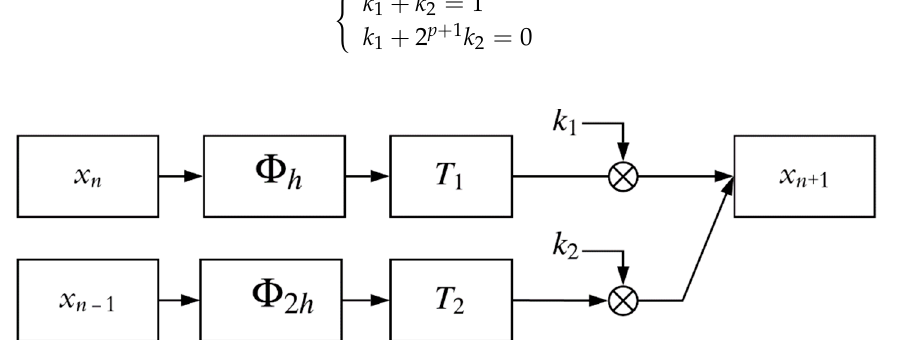
Figure 1. Graphical interpretation of the proposed multistep algorithm: solution T 1 obtained with stepsize h from the point x n and solution T 2 obtained with stepsize 2h from the point x n − 1 are combined to obtain a higher-order solution. Basic integration methods are denoted as Φ h and Φ 2 h with respect to the stepsize.